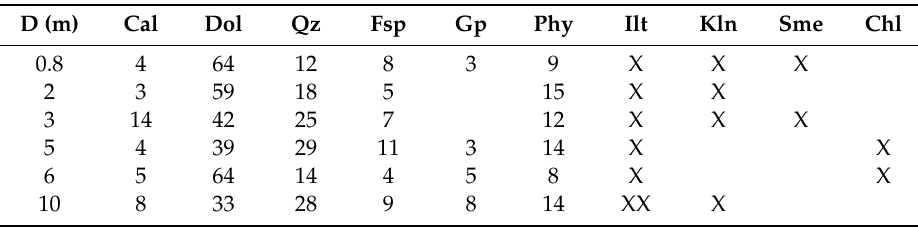
Table 1. X-ray di ff raction (XRD) analysis of the samples from the northern segment of the Baza Fault (Cañada Gallego site). The distance corresponds to the distance from fault, which is also shown on the x-axes of the plots in Figure